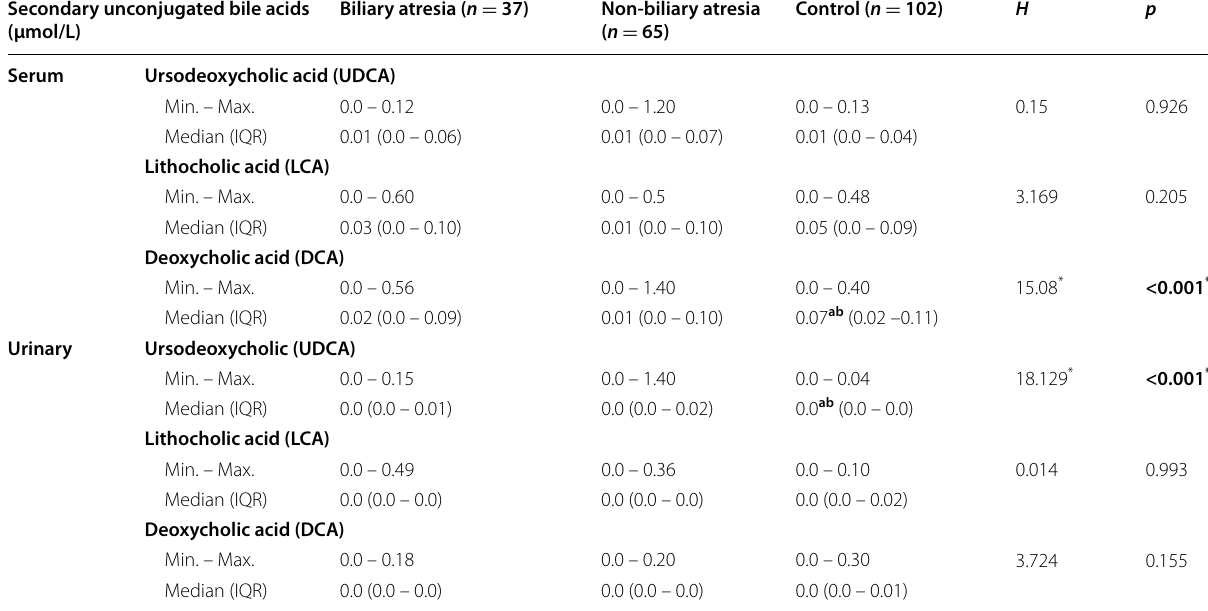
Table 6 Comparison between the two cholestatic groups (BA & non‑BA) and control regarding secondary unconjugated bile acids in serum and urine (μmol/L) Secondary unconjugated bile acids (μmol/L)